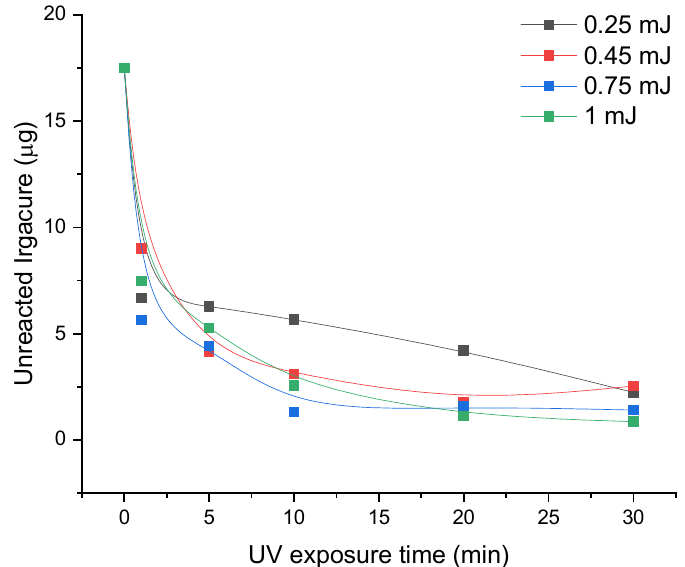
wavelength using a calibration curve determined from the absorption spectra measured for seven concentrations between 0.001 mg/Ml–0.3 mg/mL of Irgacure in ultrapure water. Knowing the concentration of unreacted Irgacure and the volume of water (3 mL) in which the hydrogel was immersed one can determine its quantity. The resulting quantities as a function of exposure time for laser energy between 0.25 mJ and 1 mJ are depicted in Figure 2. The initial amount of Irgacure used for the formation of hydrogels in the 35 µ L volume was 17.5 µ g.